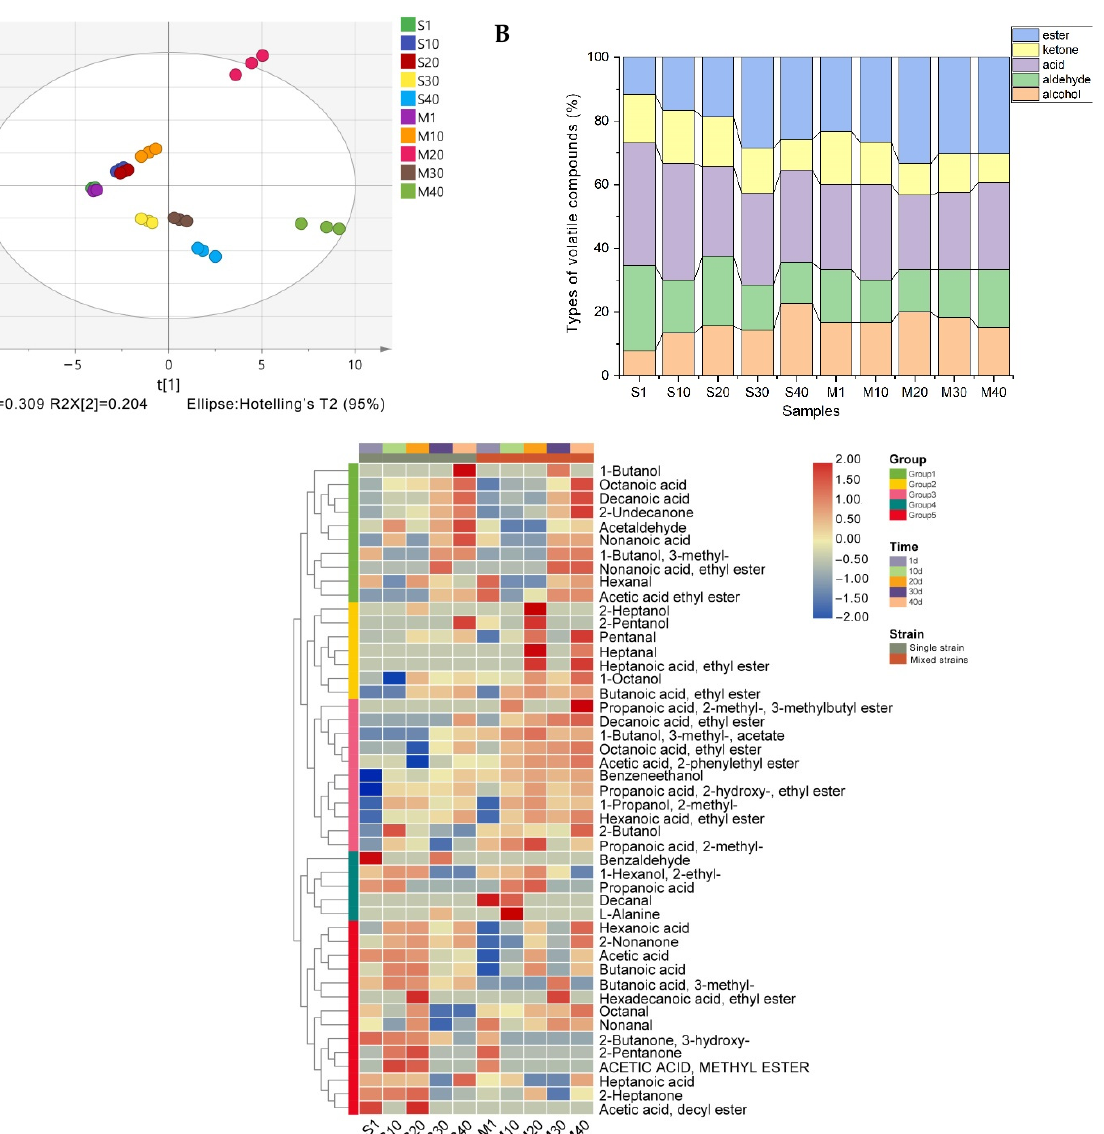
Figure 3. ( A ) Principal component analysis of cheese samples based on volatile compounds. ( B ) Types of volatile compounds in cheese. ( C ) Hierarchical cluster analysis of cheese volatile compounds during ripening. Individual cells corresponded to different cheeses and variables, which are colored red and blue to indicate high and low abundances of these variables, respectively. Abbreviations: M, mixed-fermentation cheese; S, single-strain-fermentation cheese. Numbers 1–40 represent different ripening times (in days).